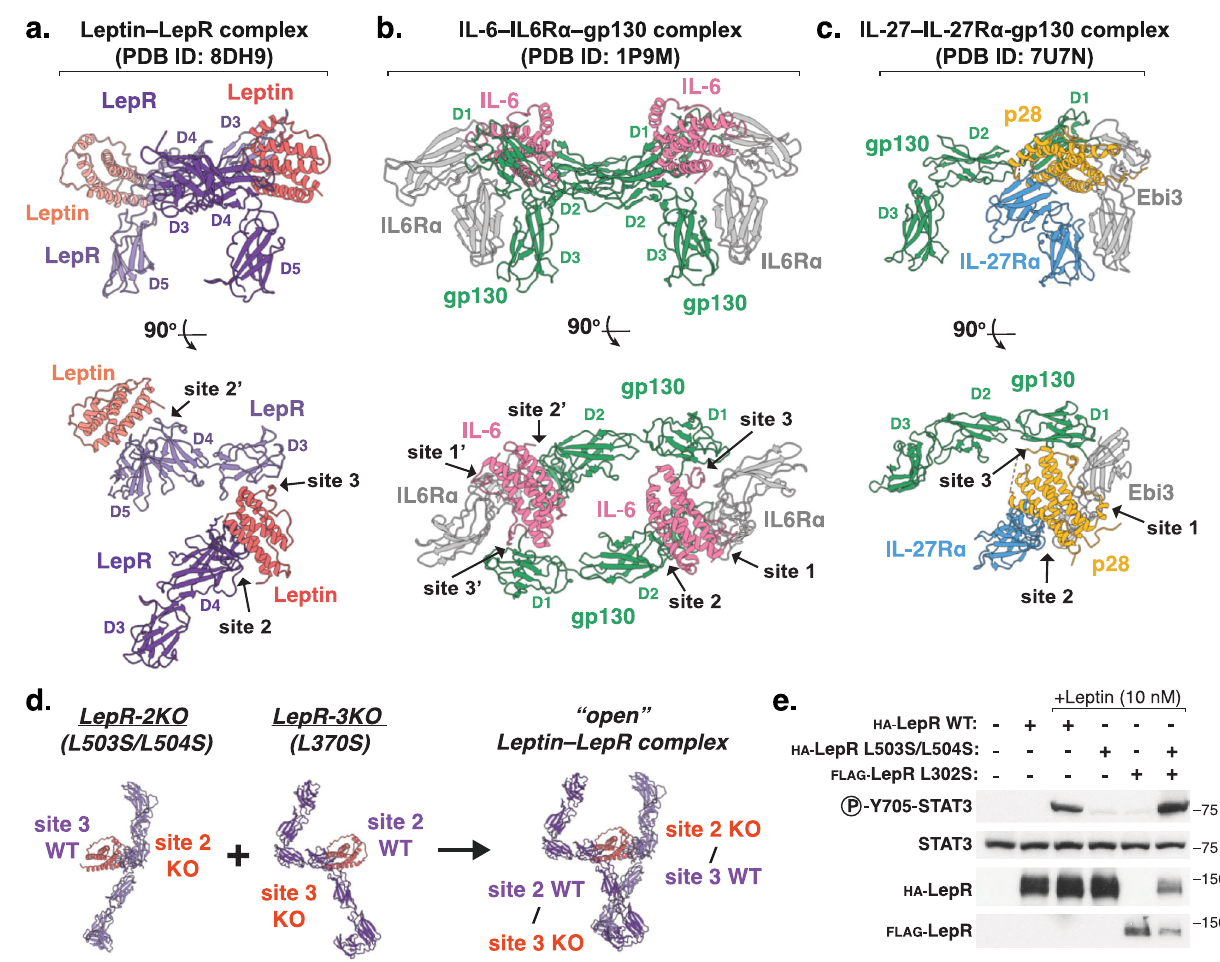
d Schematic showing how LepR mutants L503S/L504S (LepR-2KO) and L370S (LepR-3KO) assemble to exclusively form an asymmetric 1:2 leptin – LepR complex, in the same conformation as the partially open 2:2 complex observed in our structure. e Immunoblot of lysates prepared from HEK-293T cells transiently expressing the indicated LepR constructs and stimulated with 10nM recombinant leptin for 20min. Representative result of experiment performed three